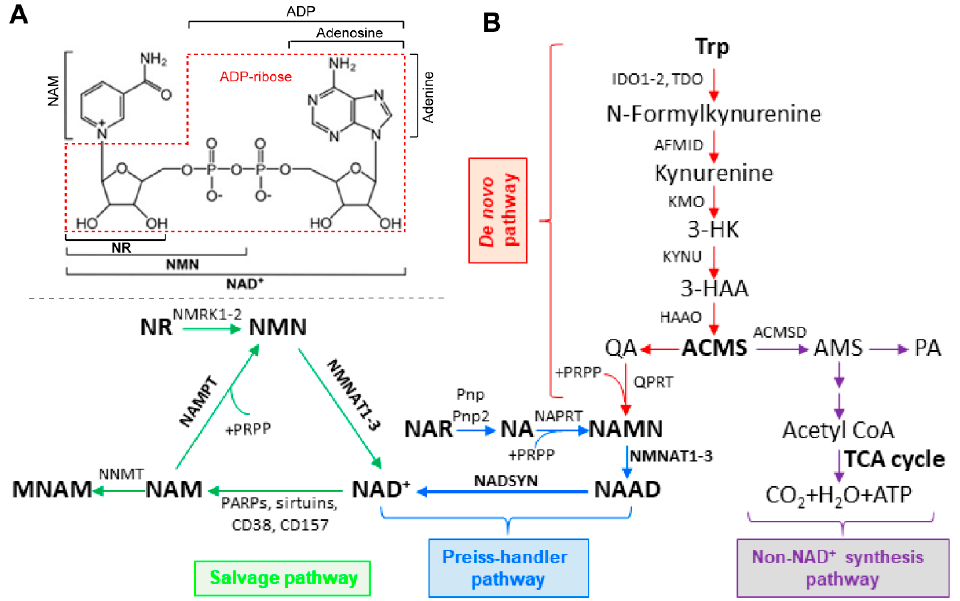
Figure 1. NAD + structure ( A ) and biosynthetic pathways in mammalian cells ( B ). 3-HK: 3-Hydroxyl- Kynurenine; 3-HAA: 3-Hydroxyl-Anthranillic Acid; AMS: α -aminomuconate semialdehyde; MNAM: methyl-nicotinamide; NAR: Nicotinic Acid Riboside; NNMT: Nicotinamide N-methyltransferase; PA: Picolinic Acid; Pnp: Purine Nucleoside Phosphorylase; PRPP: Phosphoribosyl pyrophosphate.